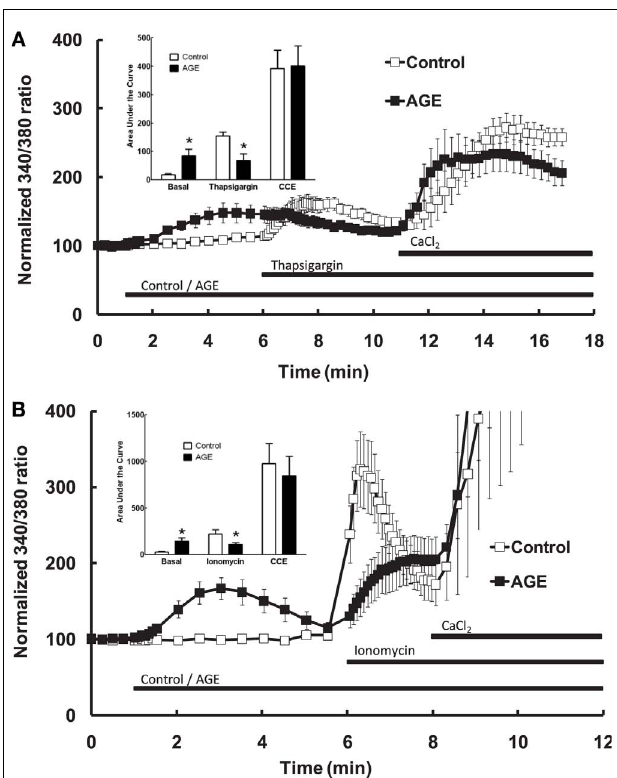
FIGURE 5 | Effect ofAGEs on thapsigargin (A) and ionomycin (B)-induced Ca 2 + signaling in BAEC, in the absence of extracellular Ca 2 + . In both cases AGEs alone induced an increase in [Ca 2 + ] and inhibited the subsequent agent-induced Ca 2 + increase, but did not affect CCE upon the re-addition of extracellular Ca 2 + (CaCl 2 ). Points and columns represent the mean ± SEM of six recordings. *Indicates significant effect of AGEs compared to control ( P < 0.05, t